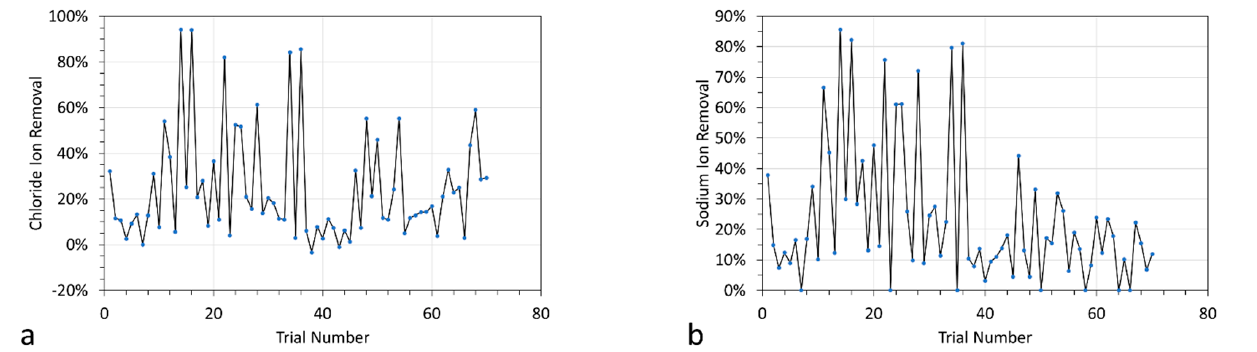
Figure 12. Ion removal: ( a ) chloride; ( b ) sodium.